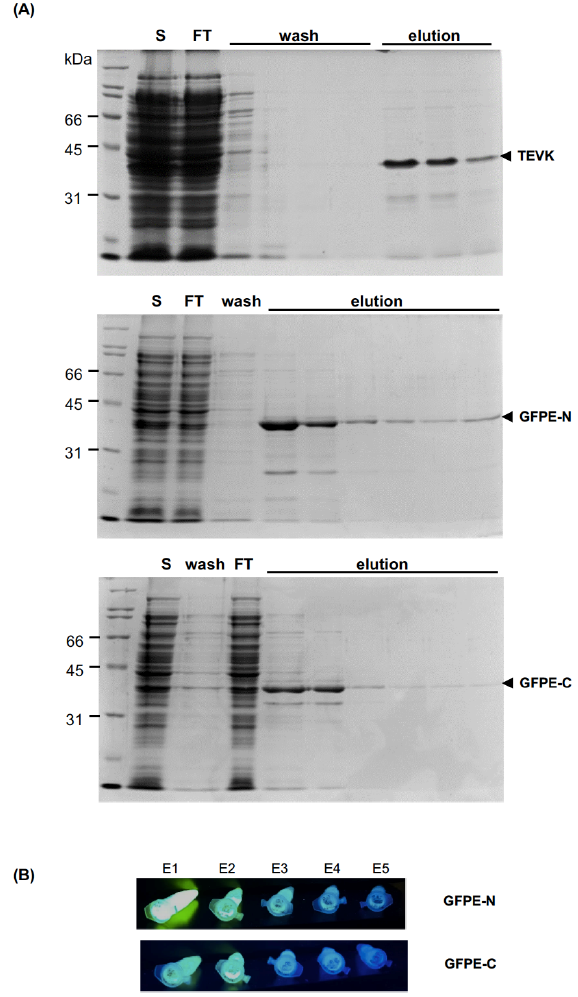
Figure 5. Purification of TEVK, GFPE-N and GFPE-C proteins by IMAC. ( A ) Analysis of the purifica- tion process by SDS-PAGE. S: Soluble fraction of bacterial lysate; FT: soluble fraction flowthrough; wash: wash solution flowthrough; elution: elution fractions. ( B ) Fluorescence of GFPE-N and GFPE-C versions in the elution